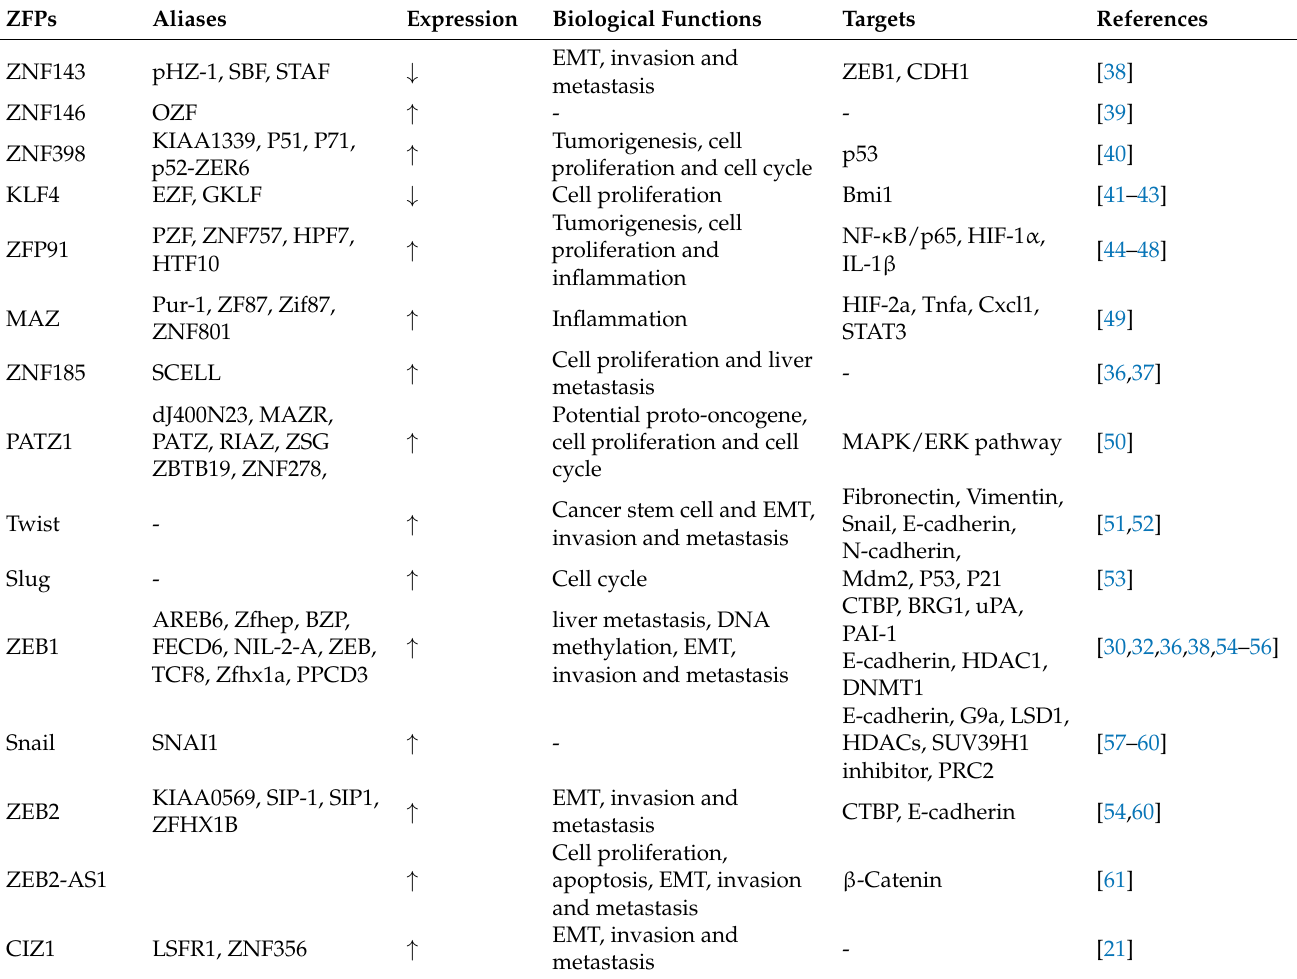
Table 1. Representative ZFPs and the related signaling pathways in colon